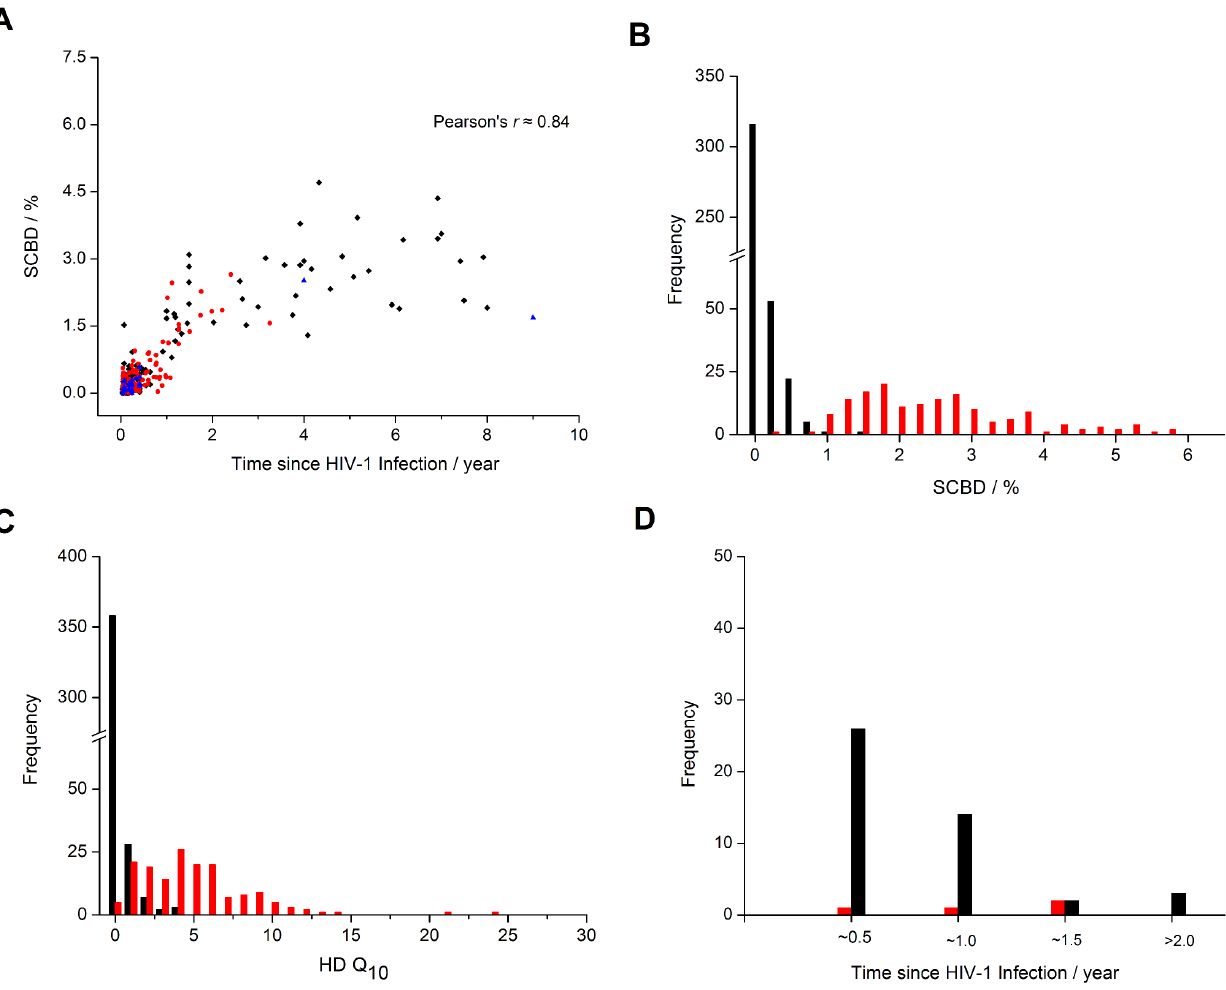
Figure 2. The SCBD dynamics and distribution of D561. (A) The SCBD dynamics in D561. Black diamonds denote subtype B samples, red dots denote subtype C samples, and blue triangles denote samples with other or unknown subtypes. (B) The distribution of the SCBD values in D561. The black histogram denotes the 398 incident infections (including 295 single- and 103 multiple-strain infections), and the red represents the other 163 chronic samples. (C) The distribution of the HD Q 10 values in D561. (D) The red histogram represents the 4 misclassified samples by our SCBD method, including 2 false positive incident infections and 2 false negatives; the black histogram denotes the 45 misclassified samples by the HD Q 10 method, including 5 false positives and 40 false negatives.